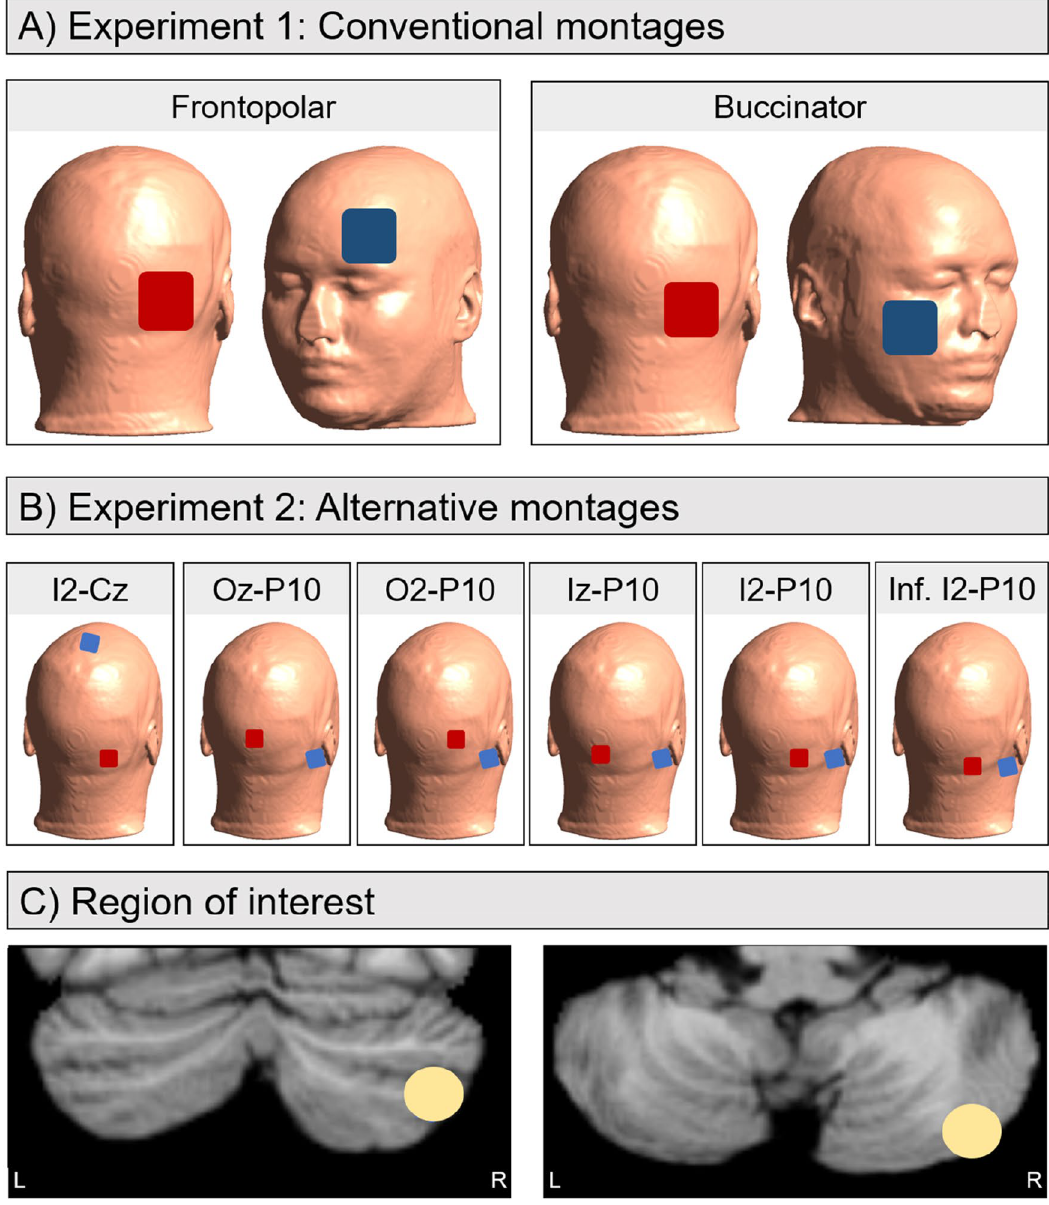
Figure 1. ( A and B ) Illustration of the electrode positions for conventional montages ( A ) and alternative montages ( B ). For the conventional montages, two electrode sizes were tested: 35 cm 2 (not pictured) and 25 cm 2 . The alternative montages used 9 cm 2 electrodes. Red electrodes refer to the anode, blue electrodes refer to the cathode. ( C ) Illustration of the region of interest (MNI coordinates: x = 40, y = − 76, z = − 46; 5 mm radius) used in the current study, plotted on coronal (top) and axial (bottom) views of a standard MNI